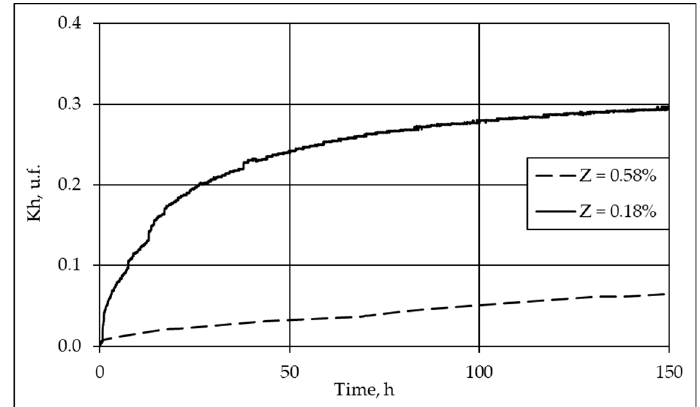
Figure 11. Time-dependent pore methane hydrate formation in silt 3 with salinities (Z) 0.58% and 0.18% at (cid:442) 4 °C.